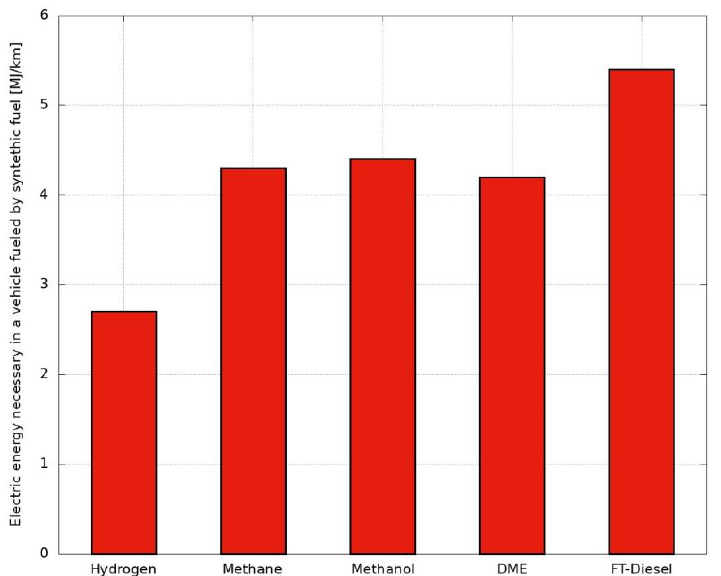
Figure 8. Electric energy necessary for reaching the distance of 1 km depending on the type of fuel — WtM analysis (Data source [15]).